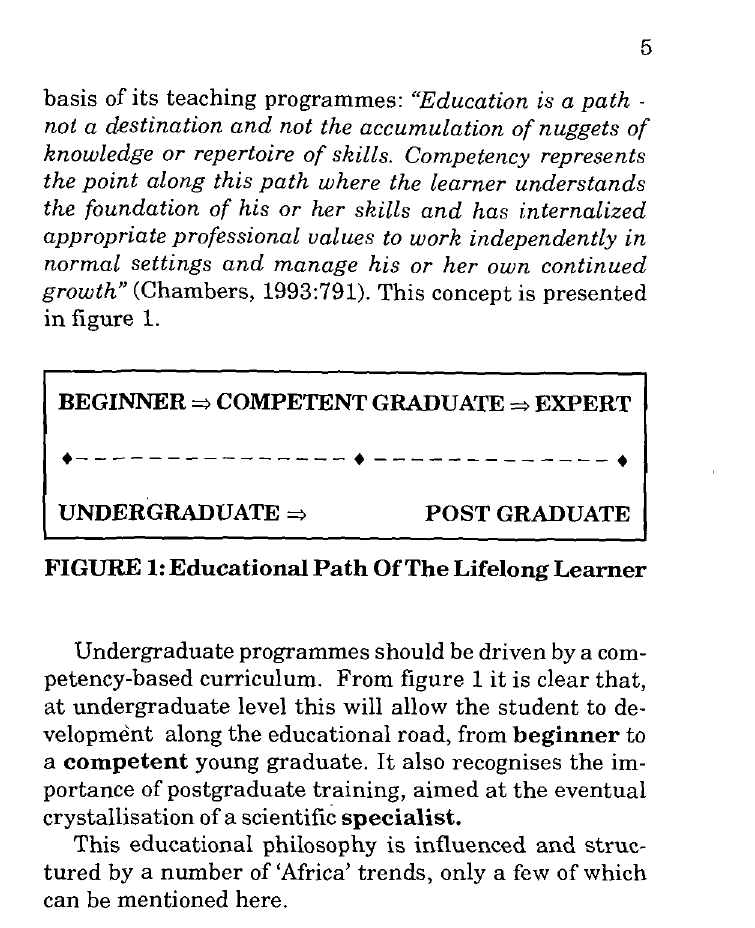
FIGURE 1: Educational Path Of The Lifelong